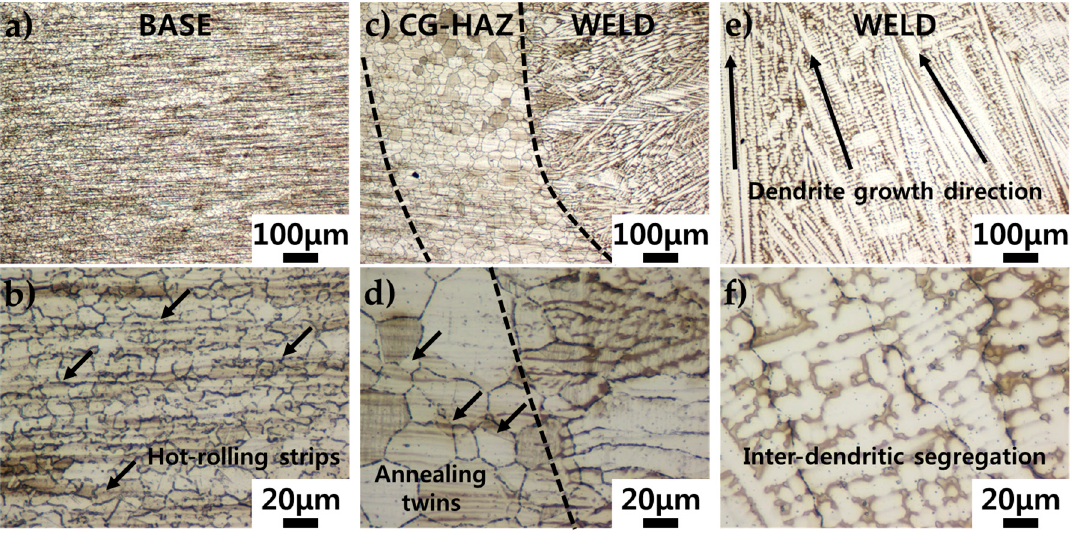
Figure 2. Optical micrographs of the as-welded specimen etched by 10% nital for 30 s and Klemm’s I for 10 s: ( a , b ) base metal, ( c , d ) heat affected zone and ( e , f ) weld zone.